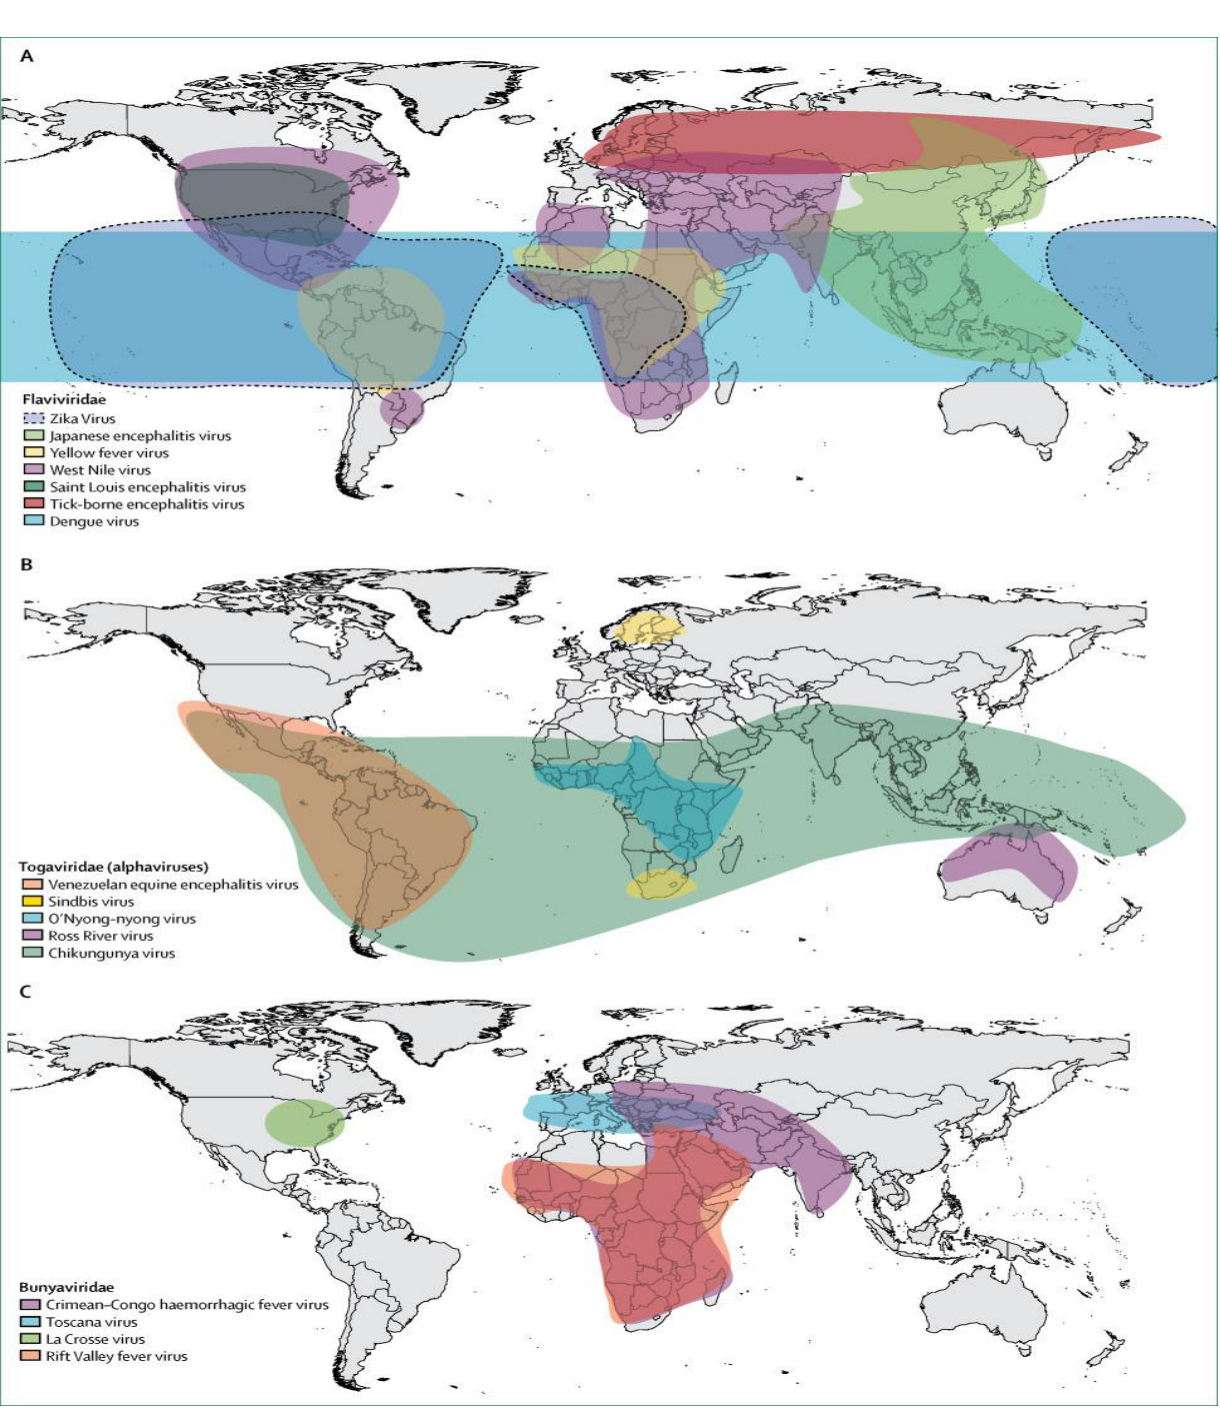
Figure 1. Global distribution of major arboviruses [7]. The Aedes -borne arboviruses described in this review belong to the Flaviviridae (ZIKV — light blue; YFV — yellow; DENV — blue) and Togaviridiae (CHIKV — green) families. Reproduced with permission from Elsevier; License no. 4892881108152.